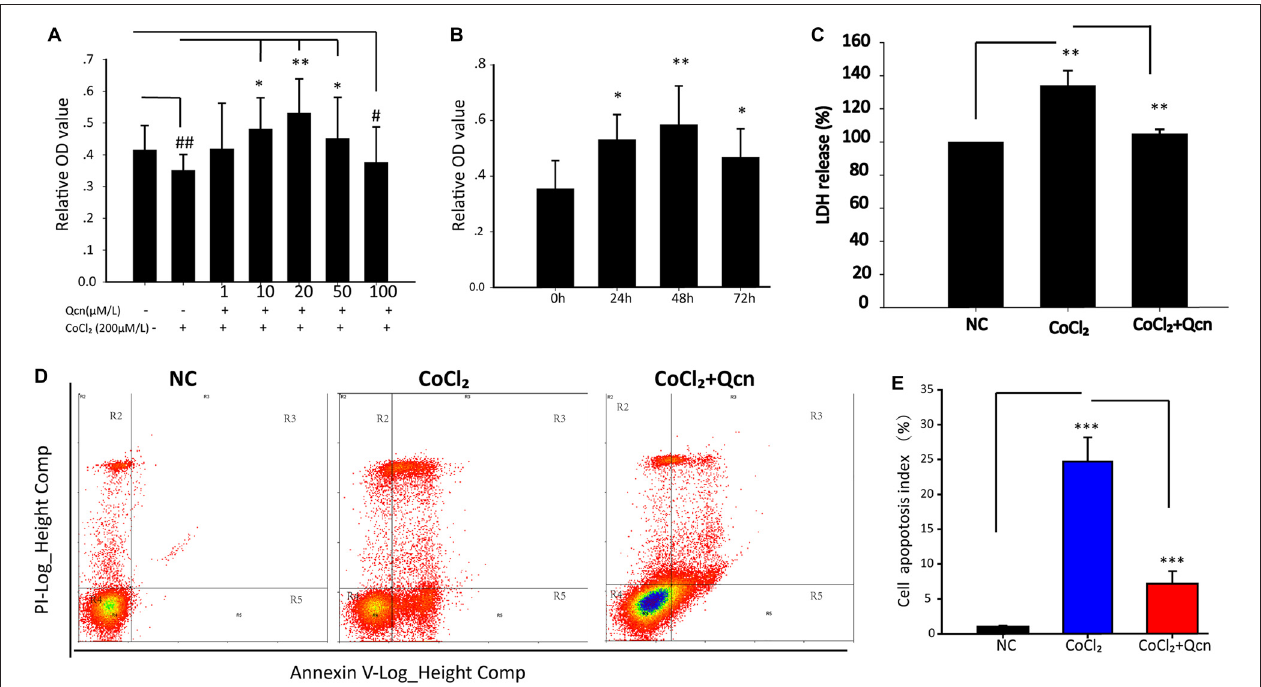
FIGURE 6 | (A) The cell viability of RGCs treated with 0–100 µ M Qcn with or without CoCl 2 was measured by the CCK-8 assay. Bars indicate the mean ± SD; # p < 0.05 and ## p < 0.01 compared with the NC group. ∗ p < 0.05 and ∗∗ p < 0.01 compared with the CoCl 2 without Qcn group. (B) RGC viability when treated with 20 µ M Qcn and 200 µ M CoCl 2 for 0, 24, 48 and 72 h. Bars indicate the mean ± SD. ∗ p < 0.05 and ∗∗ p < 0.01 compared with 0 h. (C) The impact of Qcn on lactate dehydrogenase (LDH) release of RGC treated with 20 µ M Qcn and 200 µ M CoCl 2 for 48 h. Bars indicate the mean ± SD. ∗∗ p < 0.01 when the hypoxia group was compared with the NC and CoCl 2 +Qcn groups. (D) Cell apoptosis detected by AnnexinV and propidium iodide (PI) staining in RGCs treated with 20 µ M Qcn and 200 µ M CoCl 2 for 48 h. The R4 quadrant (Annexin V − /PI − ), R5 quadrant (Annexin V+/PI − ) and R3 quadrant (Annexin V+/PI+) indicate the percentages of viable cells, apoptotic cells and necrotic cells, respectively. (E) The percentage of apoptotic cells after CoCl 2 treatment with or without Qcn. The values represent the mean ± SD of three independent experiments. ∗∗∗ p <